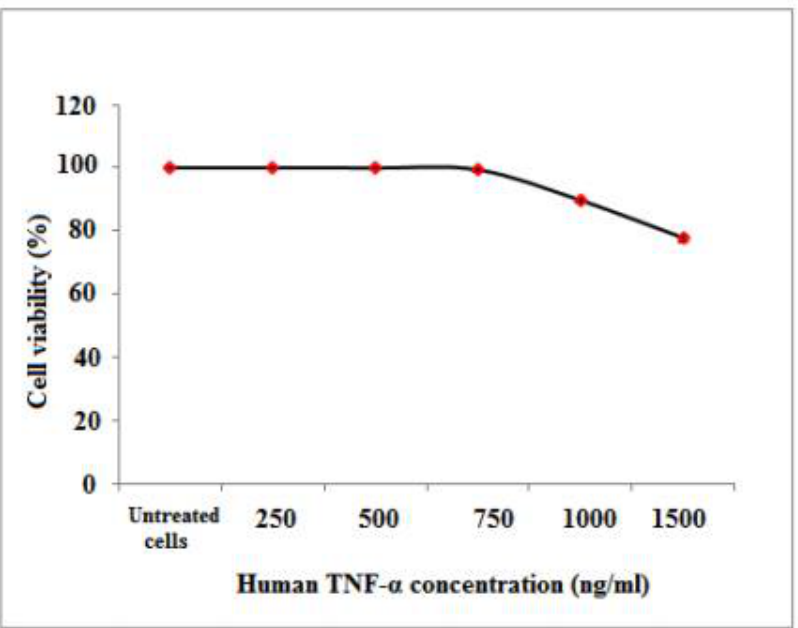
Figure 11. Percentage of cell viability of PBMCs upon treatment with different cell-free synthesized human TNF- α concentrations please remove the mouse, we uploaded original image. Table 10. IC 50 and EC 100 of cell-free synthesized human TNF- α on PBMCs.